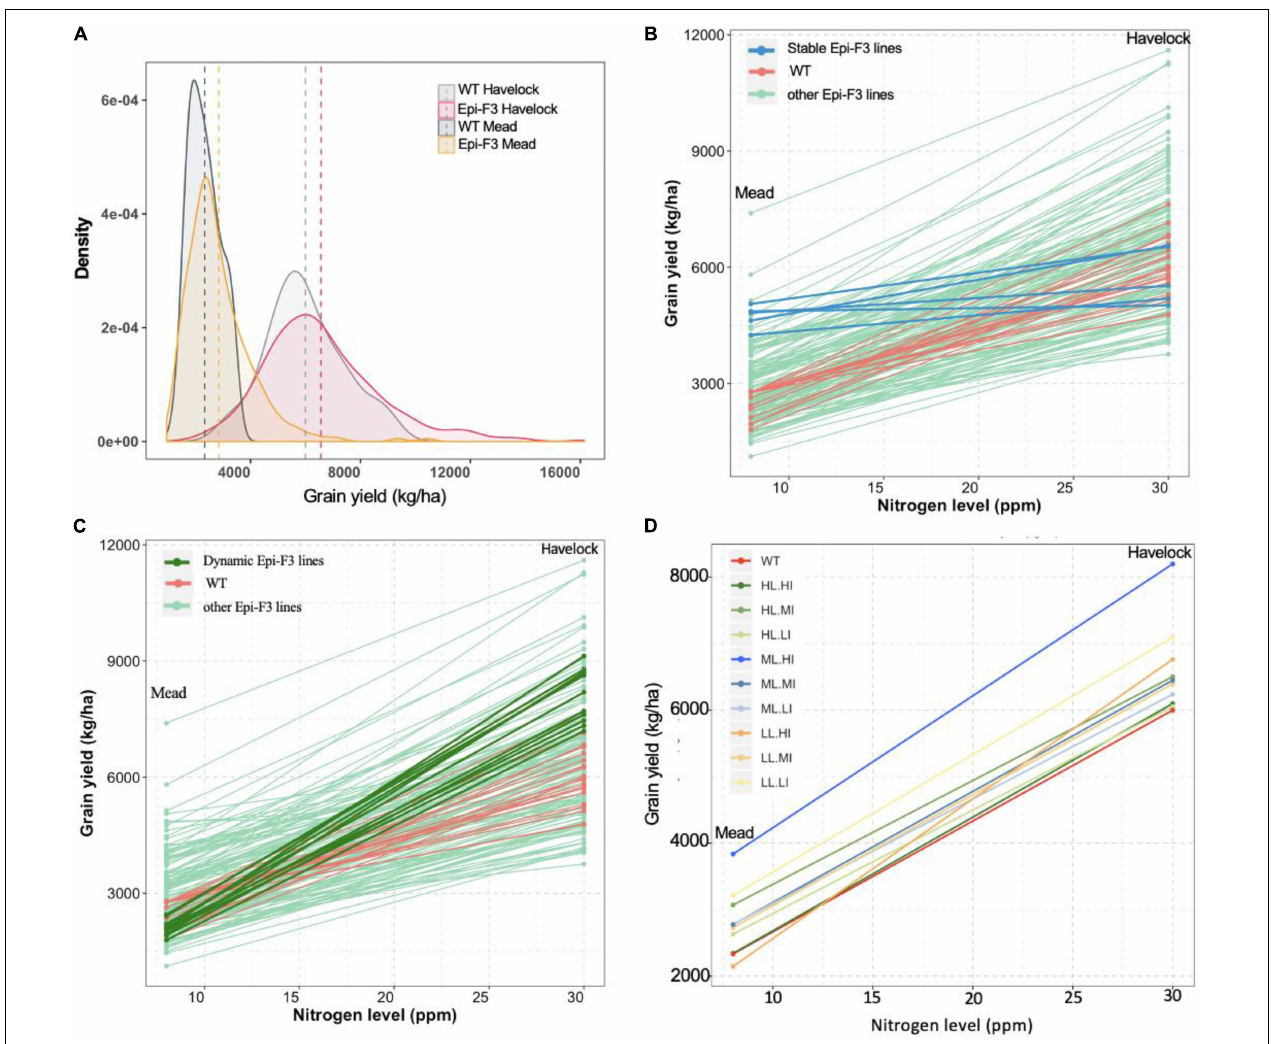
FIGURE 4 | Epi-F3 line resilience in response to low nitrogen was assessed. (A) Grain yield density plot of the WT and epi-F3 lines under normal nitrogen (Havelock, 30 ppm of nitrogen) and low nitrogen (Mead, 8 ppm of nitrogen) conditions. (B,C) Grain yield for the 150 epi-F3 lines and 19 wild-type lines, with each line in the plot representing one line, in the Havelock and Mead locations. “Stable” epi-F3 lines (epi-line yield differential < 30%) are highlighted in blue in (B) . “Dynamic” epi-F3 lines (epi-line yield differential > 30%) are highlighted in dark green in (C) . (D) Grain yield differentials of the nine categories for selection based on line mean and individual selection (LL.LI, low line mean, low individual; LL.MI, low line mean, medium individual; LL.HI, low line mean, high individual; and so on). Each line represents a category, and dot represents the average grain yield of all treatments in the given category in the indicated location. For each category, at least 10 lines were included, with three categories having 30 lines (LL.MI, ML.MI, and